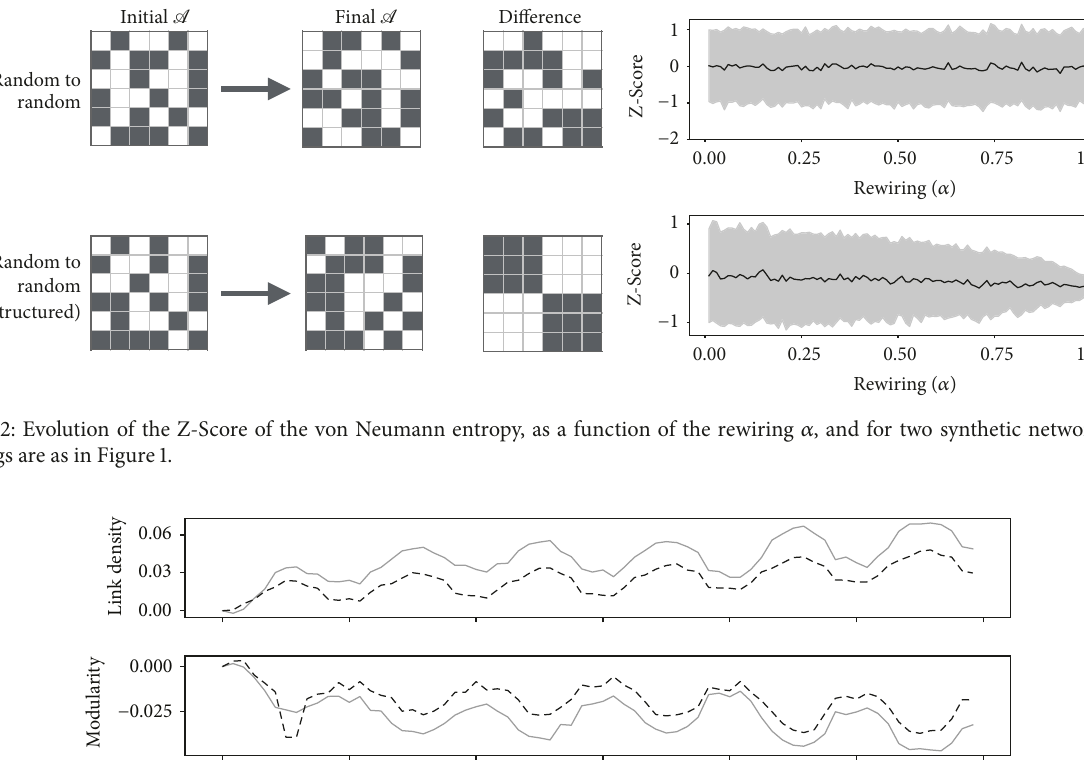
average shortest path length is 2.07 ± 0.38 , and the median clustering coefficient is 0.46